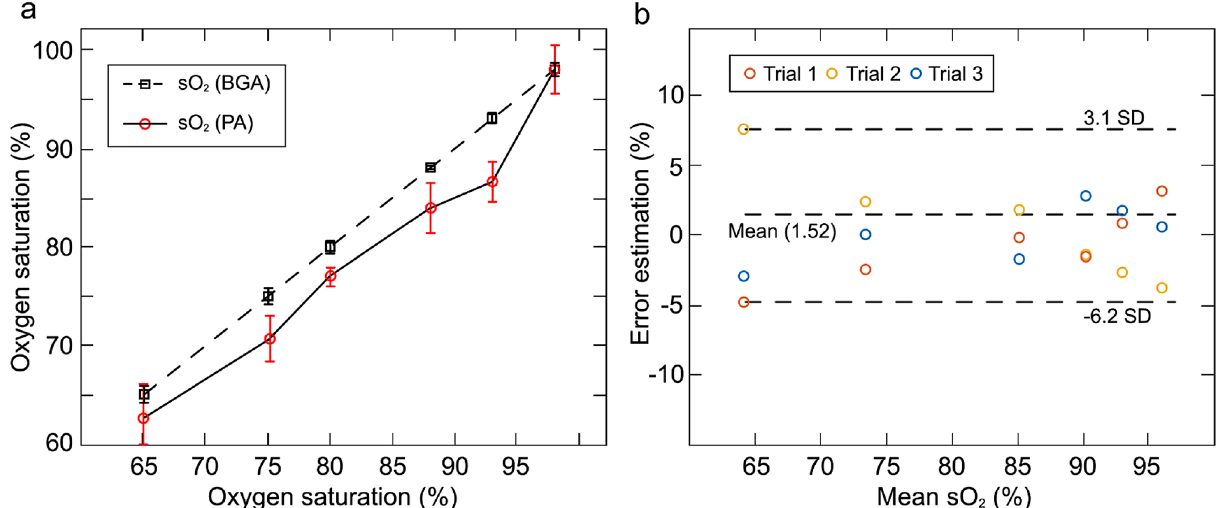
Figure 4. Photoacoustic Oxygen saturation (PA-sO 2 ) validation. (a) PA estimated sO 2 plotted against measured sO 2 from blood gas analyzer. Error bars represent standard deviation (SD) among the trials 1–3, (b) Bland– Altman estimation analysis plot showing error estimation for all trials. SD: standard